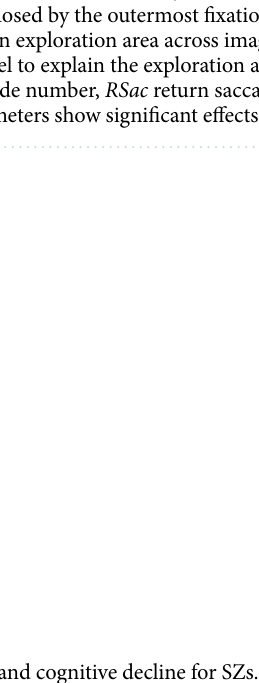
Impairment of IOR in SZs persisted over a few cycles of fixations and saccades (Fig. 3e–l). SZs made more return saccades than HCs to two-back (7.3 ± 3.7% for SZs, 5.3 ± 2.2% for HCs; z = 6.06, p < 0.001, d’ = 0.80, AUC = 0.68) and three-back locations (6.0 ± 2.9% for SZs, 4.4 ± 1.9% for HCs; z = 6.35, p < 0.001, d’ = 0.76, AUC = 0.69). The saccade amplitude was smaller in SZs than in HCs, leading to more amplitude-matched saccades in SZs (29.8 ± 9.3%) than in HCs (23.4 ± 5.7%; z = 7.68, p < 0.001). To determine whether the increase in return saccades in SZs merely reflected a greater number of amplitude-matched saccades, we compared the occurrence ratio of return saccades to that of amplitude-matched saccades. We found that even in this analysis, SZs made more return saccades than HCs (32.8 ± 12.6% for SZs, 27.6 ± 9.2% for HCs; z = 4.21, p < 0.001, d’ = 0.52, AUC = 0.62). To examine the effect of image salience on IOR, we analysed the return saccade probability when the par- ticipants viewed noise images. There was no difference in the salience of fixated locations between SZs and HCs (two-way ANOVA, F (1,1167) = 2.04, p = 0.15) or between return and no-return saccade locations (F (1,1167) = 0.75, p = 0.39), suggesting that the weak fluctuation of salience in the noise images had little if any effect on determin- ing the next saccade location. Nevertheless, SZs made more frequent return saccades than HCs when viewing